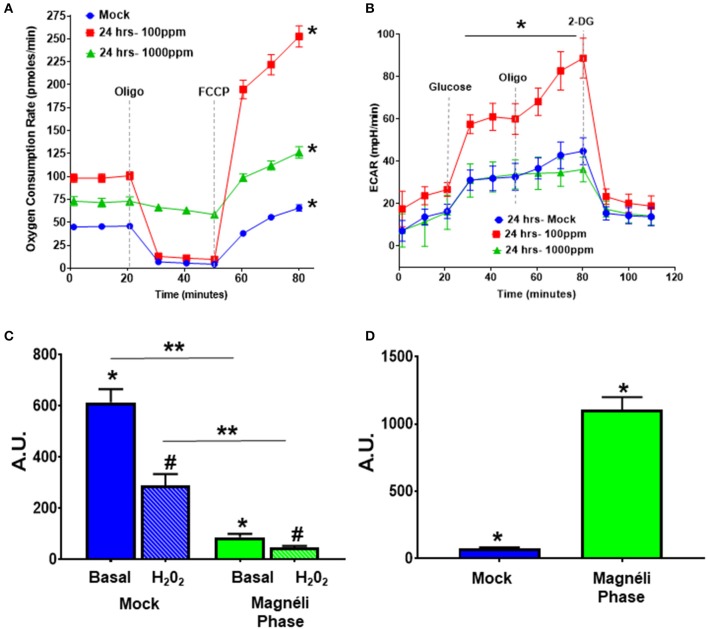
Alterations in cellular energetics and mitochondrial membrane potential in macrophages treated with Ti6O11. (A) Oxygen consumption rate (OCR) and (B) extracellular acidification rate (ECAR) were measured using Agilent Seahorse XF96 Analyzer in mock and Ti6O11 treated BMDMs at either 100 ppm or 1,000 ppm. (C) Mitochondrial membrane potential was evaluated using tetramethylrhodamine (TMRM) in macrophages treated with vehicle (blue) or 100 ppm Magnéli phases (green), with H2O2 used to induce maximum loss of membrane potential in each group. (D) Cellular oxidative stress was evaluated using dihydrodichlorofluorescein (DCF) fluorescence. All data are expressed as mean ± SEM (n = 3/group). AU, Arbitrary Units. *p < 0.05, #p < 0.05, **p < 0.01.